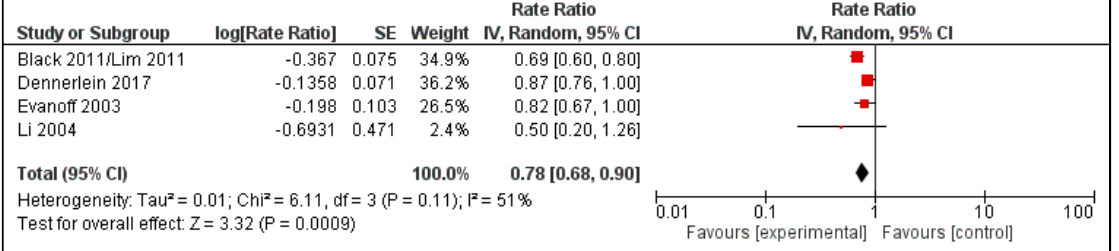
Figure 2. Forest plot of studies reporting the relative risk estimates for all musculoskeletal injuries in intervention versus control groups post ‐ intervention.